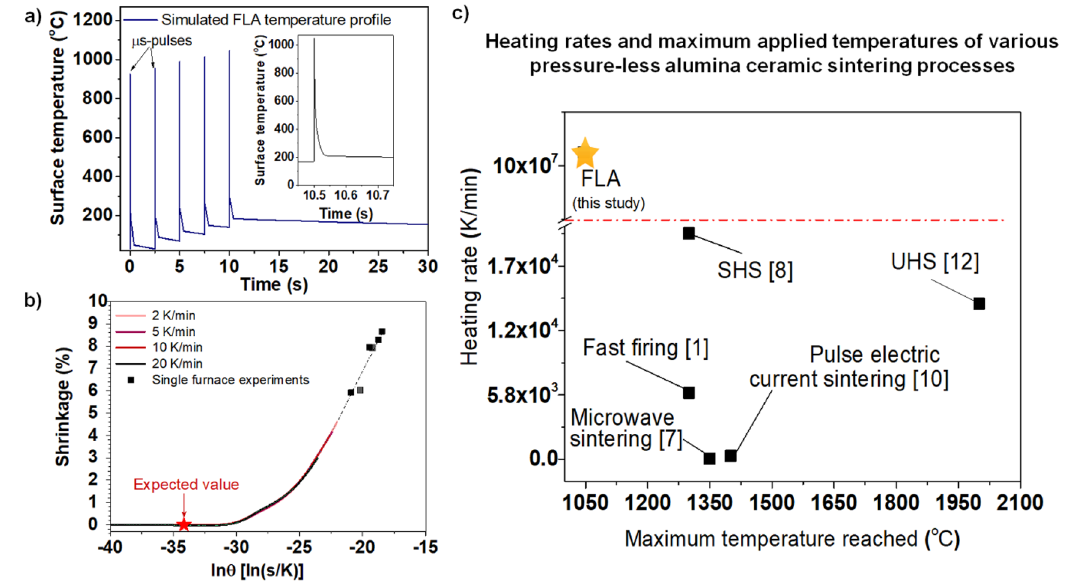
Figure 3. Characterization of the sintering process. ( a ) Simulated temperature profile obtained using SimPulse PulseForge 1300 built-in software (https ://www.novac entri x.com/produ cts/simpu lse) image shows enlarged single peak of FLA microsecond process. ( b )—inset Shrinkage of compressed Al 2 O 3 -Fe 2 O 3 powders concerning activation energy, time, and temperature term ϴ in accordance with the Master Sintering Curve concept. ( c ) Heating rate for reported sintered alumina ceramics versus maximum applied temperature during the sintering